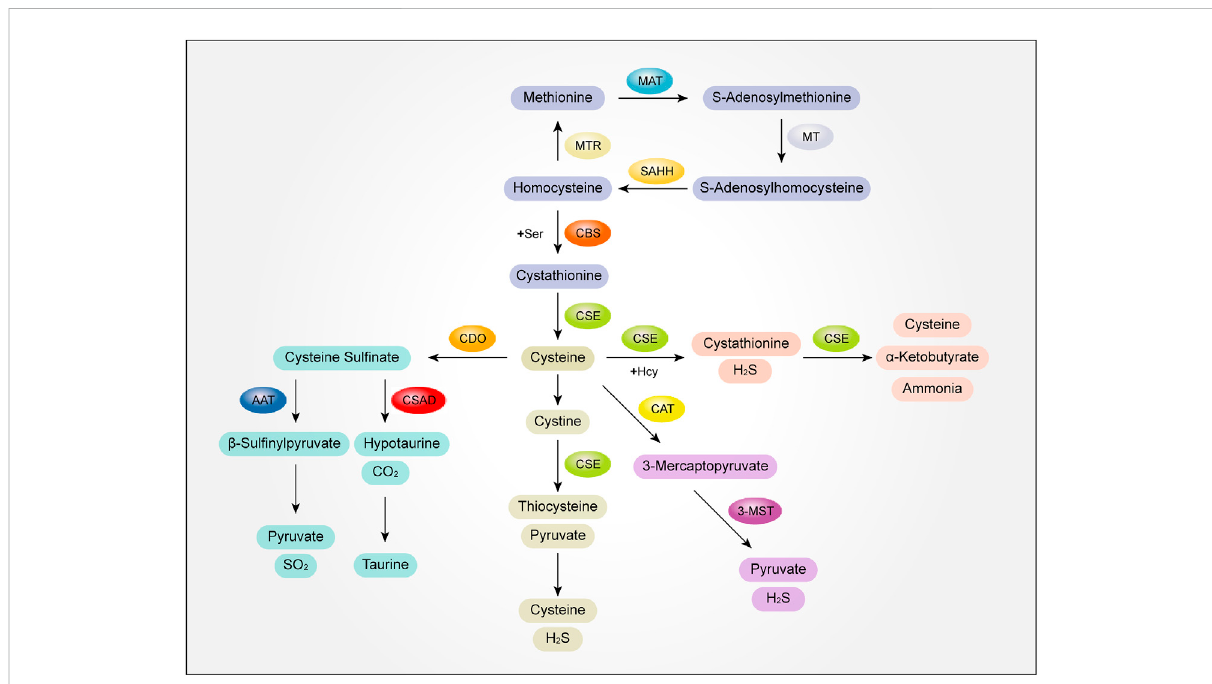
FIGURE 2 The mutual transformation mechanism of sulfur-containing amino acids and their metabolites. MAT, methionine adenosyltransferase; MT, methyltransferase; SAHH, S-adenosylhomocysteine hydrolase; MTR, methionine synthetase; Ser,serine; CBS, cystathionine β -synthase; CSE, cystathionine γ -lyase; Hcy, homocysteine; H 2 S, hydrogen sul fi de; CAT, 2-cysteine aminotransferase; 3-MST, 3-mercaptopyruvate sulfurtransfer; AAT, aspartate aminotransferase; CSAD, cysteine sul fi te decarboxylase; SO 2 , sulfur